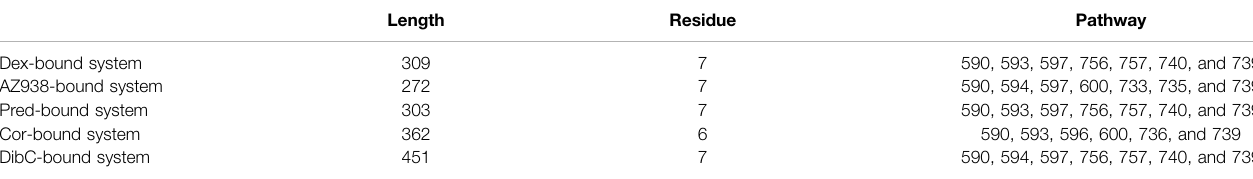
TABLE 3 | Allosteric pathway analysis between D590 and